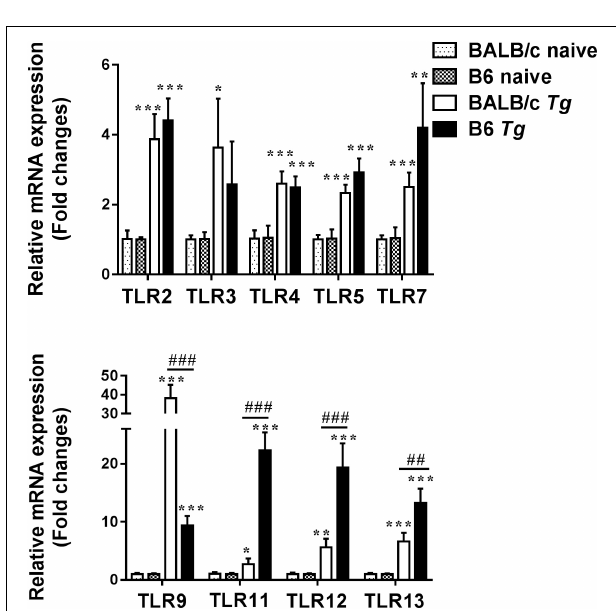
FIGURE 5 | The mRNA expressions of TLRs in the eyes of naive mice and T. gondii -infected mice were measured by using qRT-PCR. Data are presented as means ± SD; there were six mice in each group and the data represents from two experiments. ∗ P < 0.05, ∗∗ P < 0.01, and ∗∗∗ P < 0.001, T. gondii -infected mice vs. naive mice. ## P < 0.01 and ### P < 0.001, T. gondii -infected B6 mice vs. T. gondii -infected BALB/c